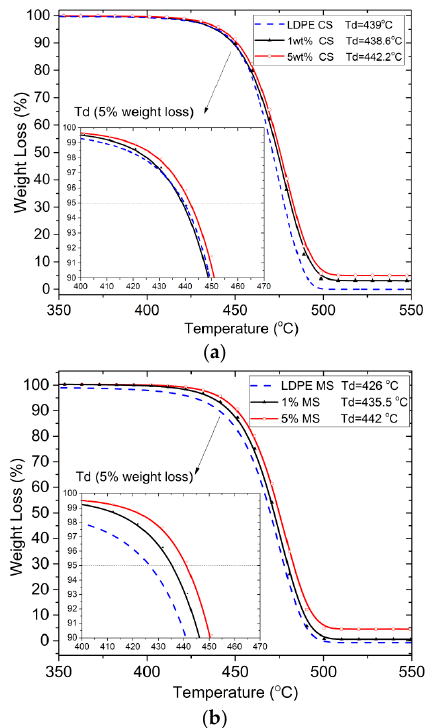
Figure 4. TGA curves measured for specimens produced with a compression screw ( a ) and with a mixing screw ( b ).